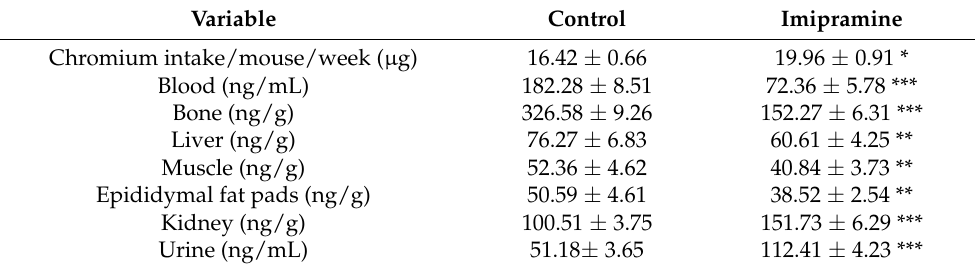
Table 3. Chromium concentrations in the organs and tissues of HFD-fed controls and imipramine- treated